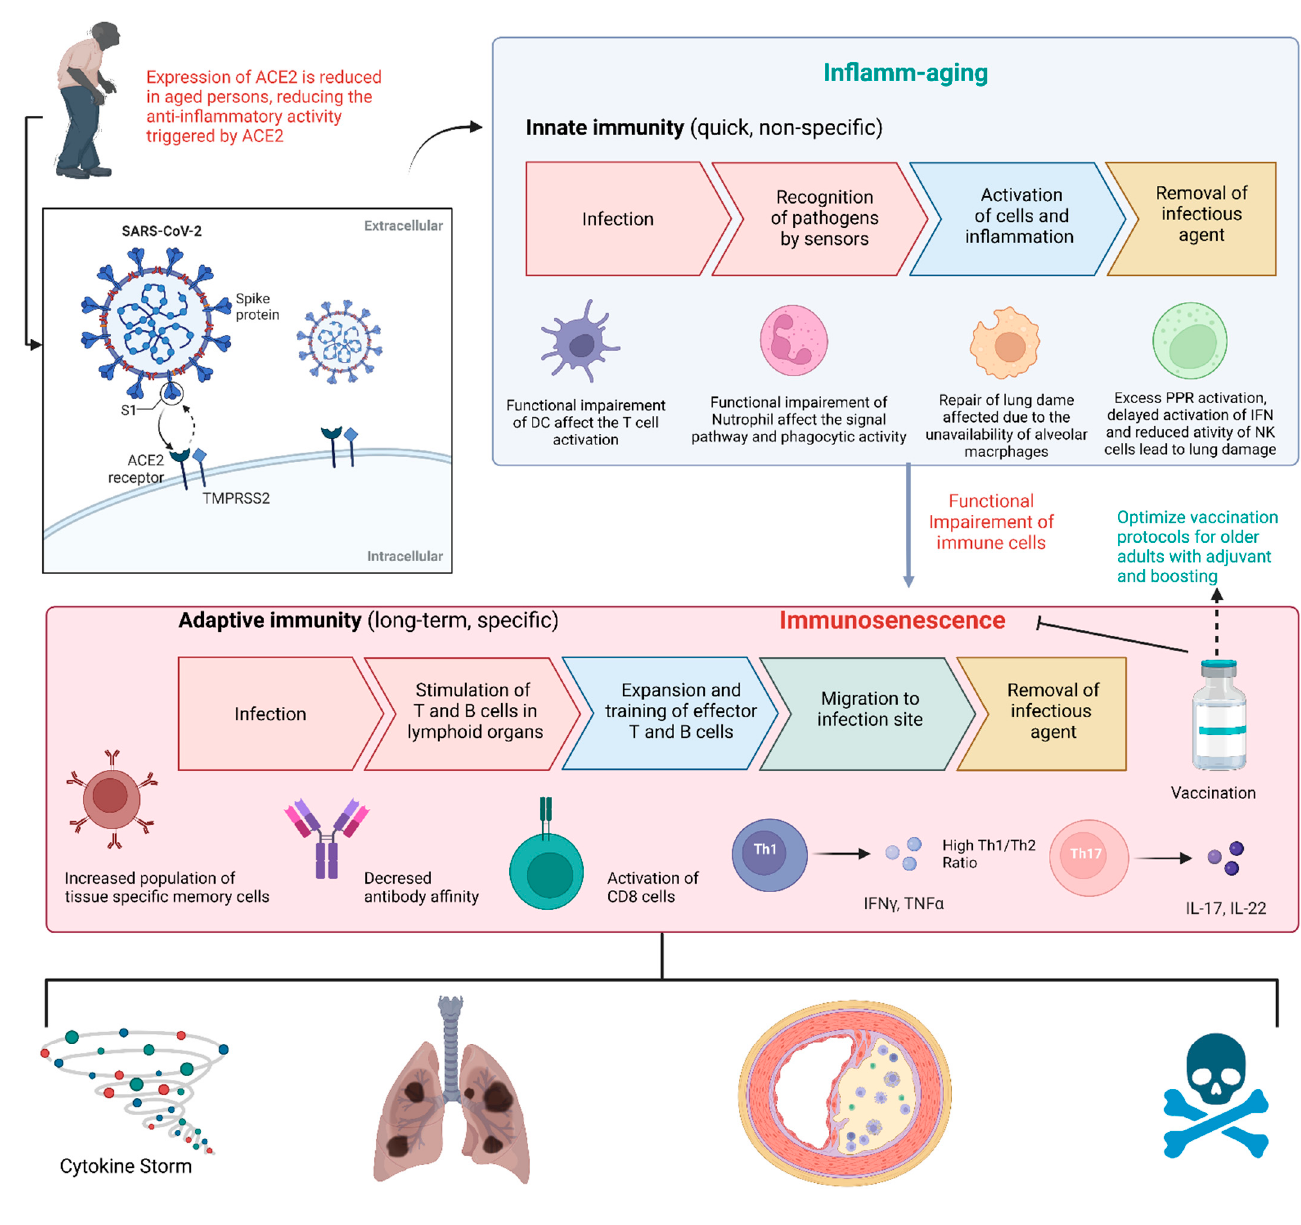
Figure 1. Alteration of the immune system in the aged population and connection with COVID-19 management.